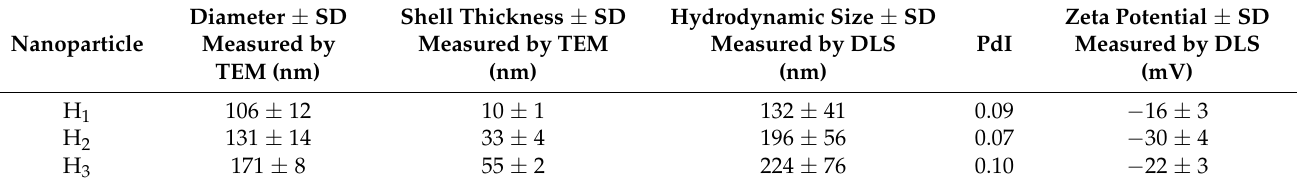
Table 1. Particle diameter and shell thickness measured by TEM, hydrodynamic diameter, polydis- persity index (PdI), and zeta potential measured by DLS, of all fabricated silica nanoparticles.